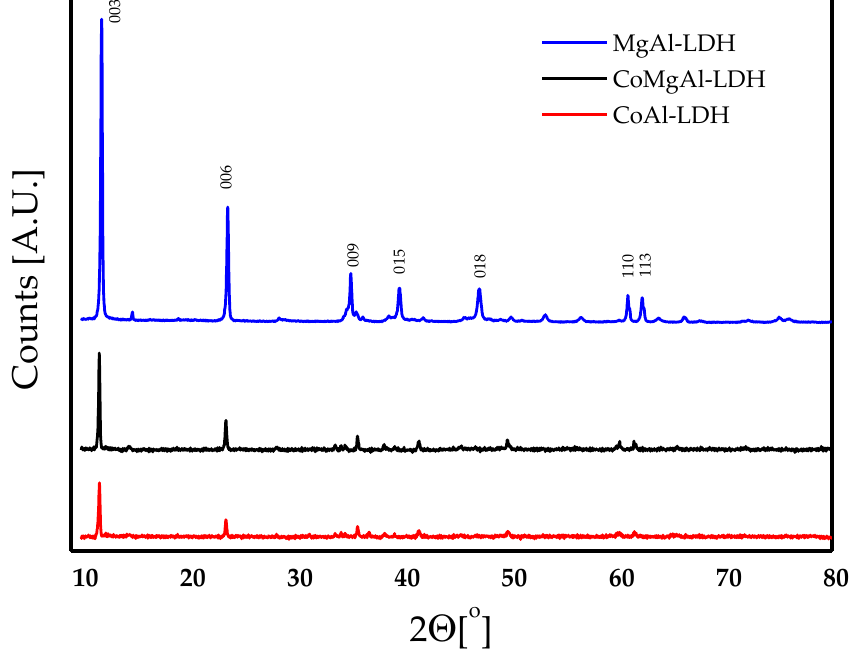
Figure 3. X-ray di ff raction (XRD) patterns of all the investigated solid Figure 3. X-ray diffraction (XRD) patterns of all the investigated solid samples.